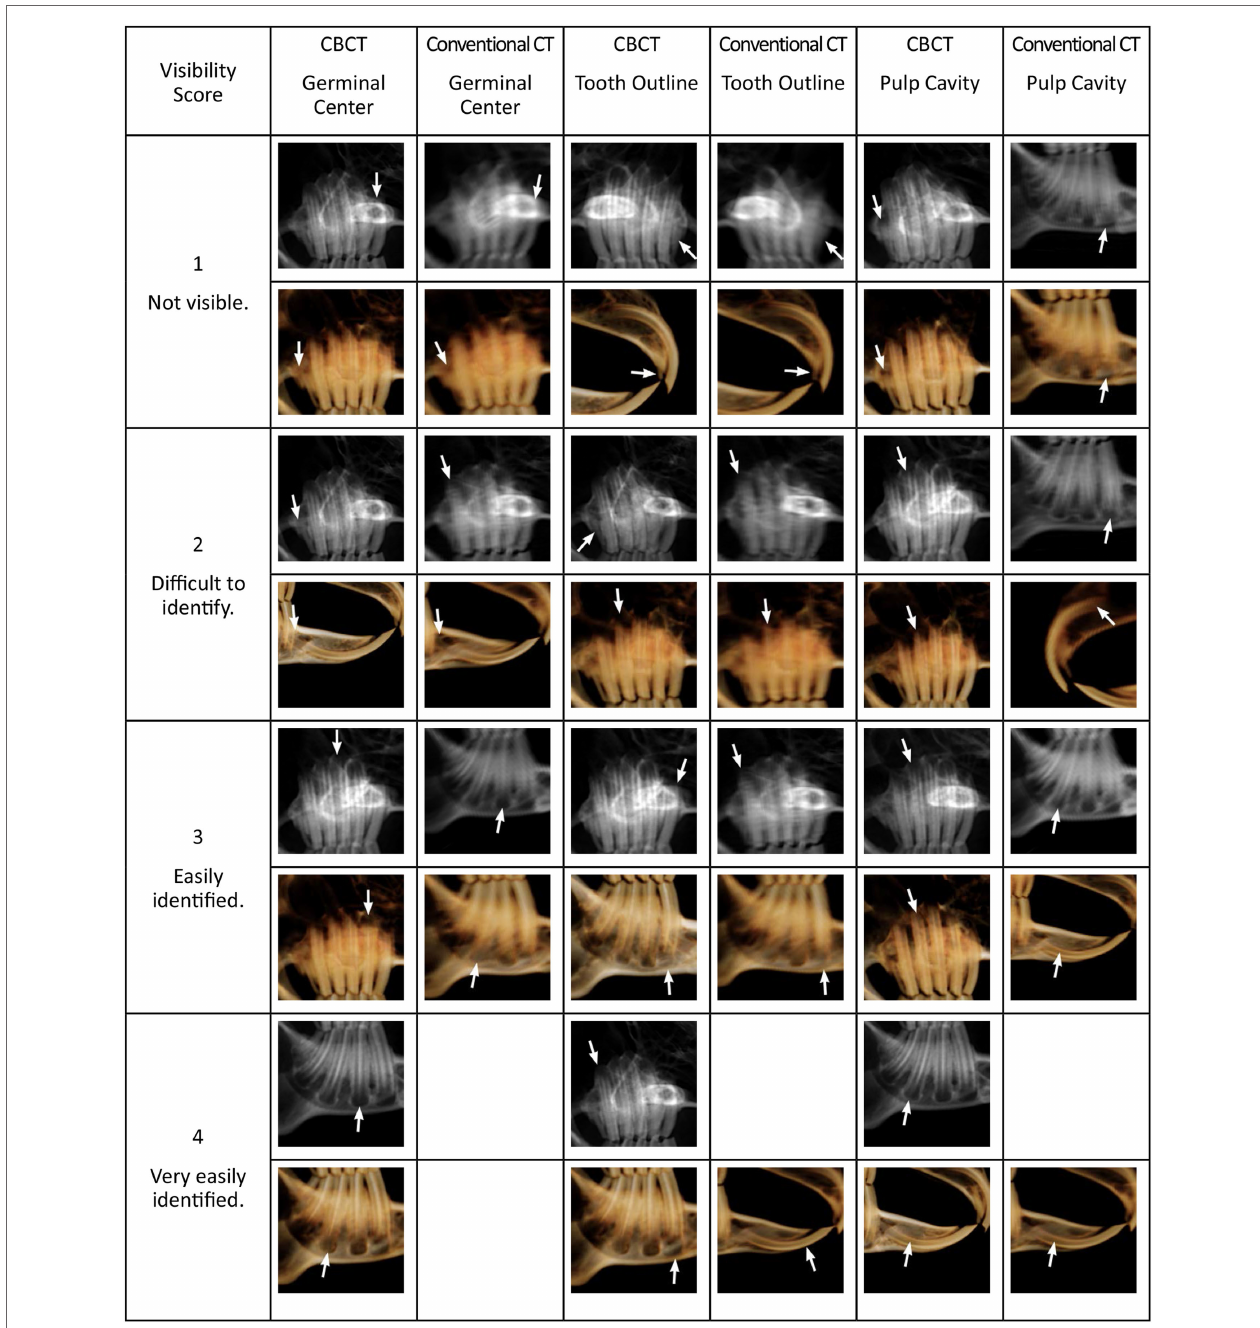
FigUre 4 | Panoramic (grayscale) and tooth view (sepia) sagittal images from cBcT and conventional cT displaying the various scores for germinal center, pulp cavity, and tooth outline visibility . The white arrows indicate the tooth and structure given the score. The zygomatic arch has been cropped from the images to facilitate viewing of the maxillary premolar and molar teeth. Blank boxes indicate that no teeth met these criteria.